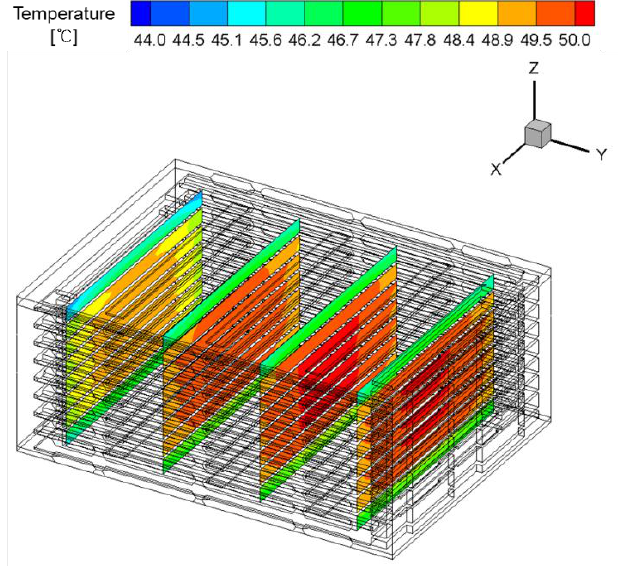
Figure 8. Temperature distributions of the LIB cells within the module at a few cross sections along the y direction at the discharge time of 960 s with the discharge rate of 3 C for natural convection